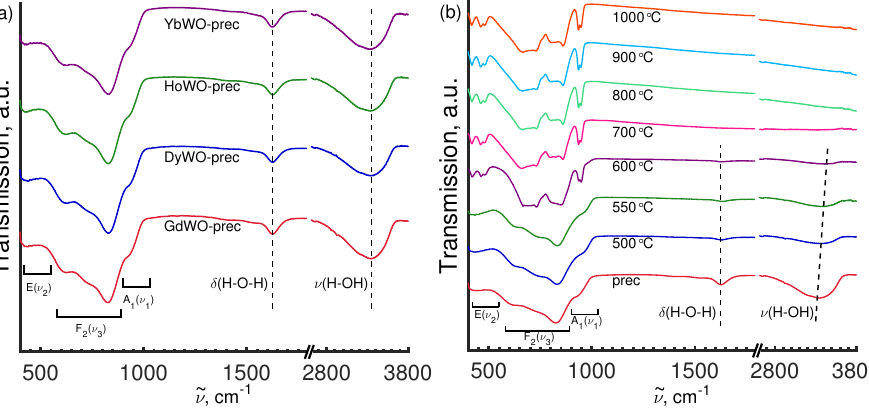
Figure 8. FT-IR spectra of Ln tungstate precursors Ln WO-prec ( a ), Gd 2 (WO 4 ) 3 samples prepared by the calcination of the precursor at different temperatures ( b